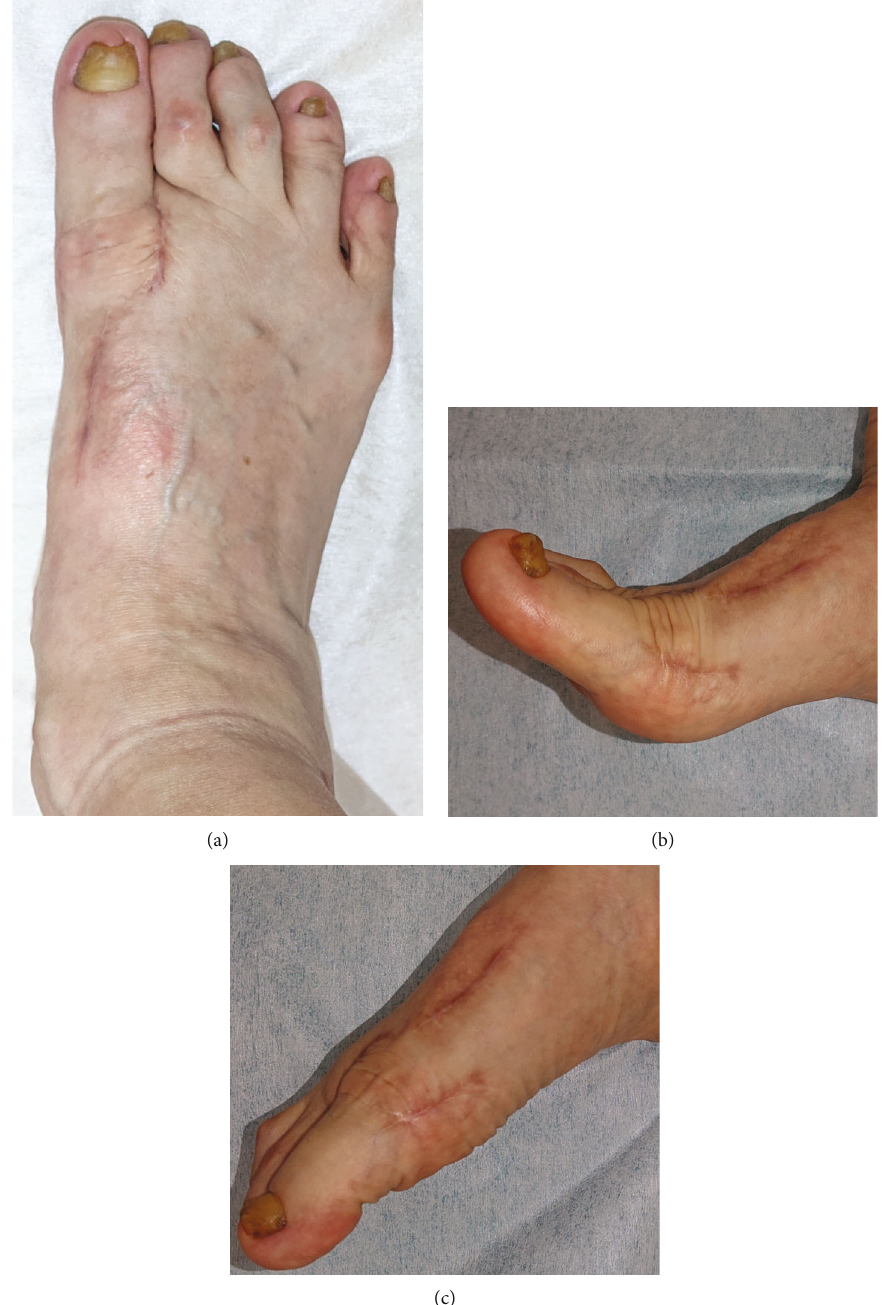
Figure 4: Appearance of the foot (a) and active motion of the great toe at one year postoperatively. (b) Dorsi fl exion. (c) Plantar fl